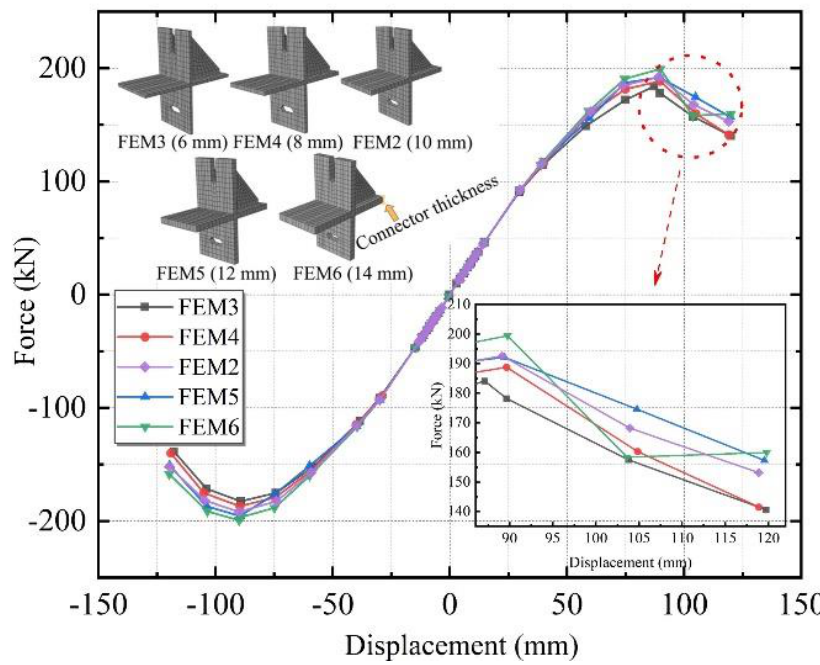
Figure 16. Skeleton curves with different specimen thicknesses.